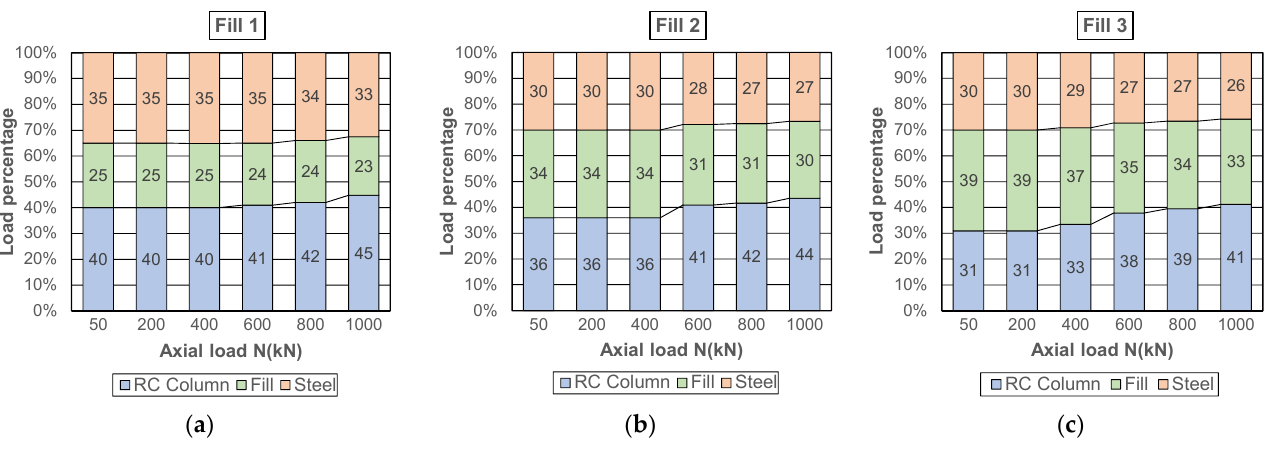
Figure 17. Experimental load distribution for strengthened specimens: B2x-Fill 1 ( a ), B4x-Fill 2 ( b ), and P0x-Fill 3 ( c ).